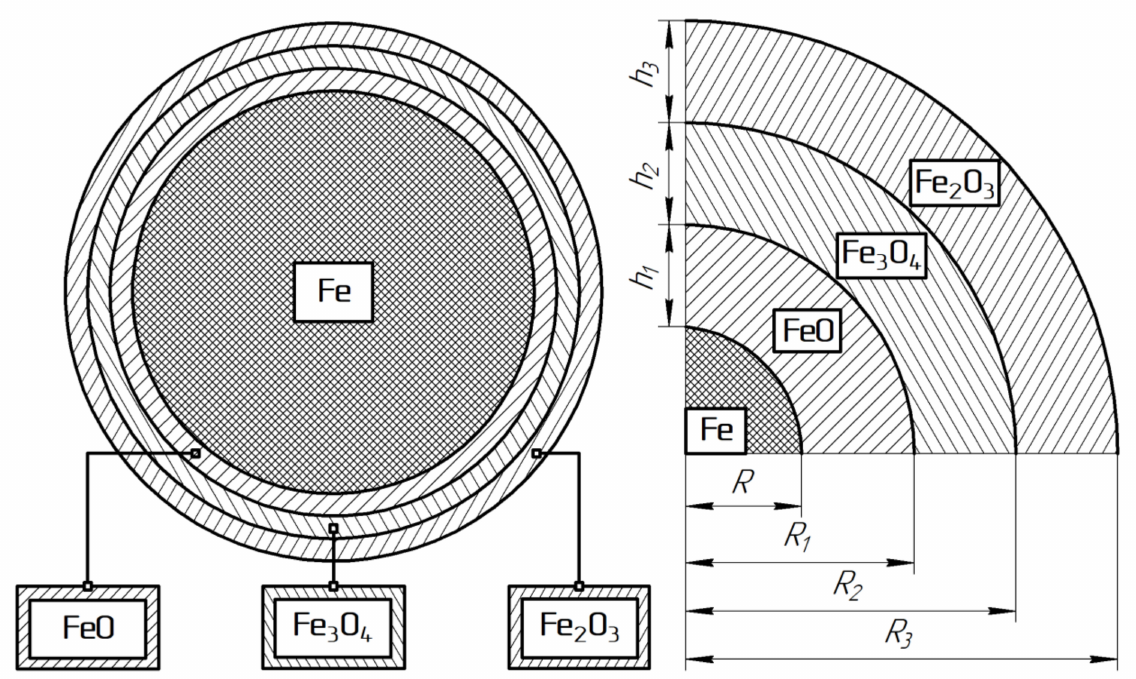
Figure 9. Model for the thickness calculation of a multiphase oxide